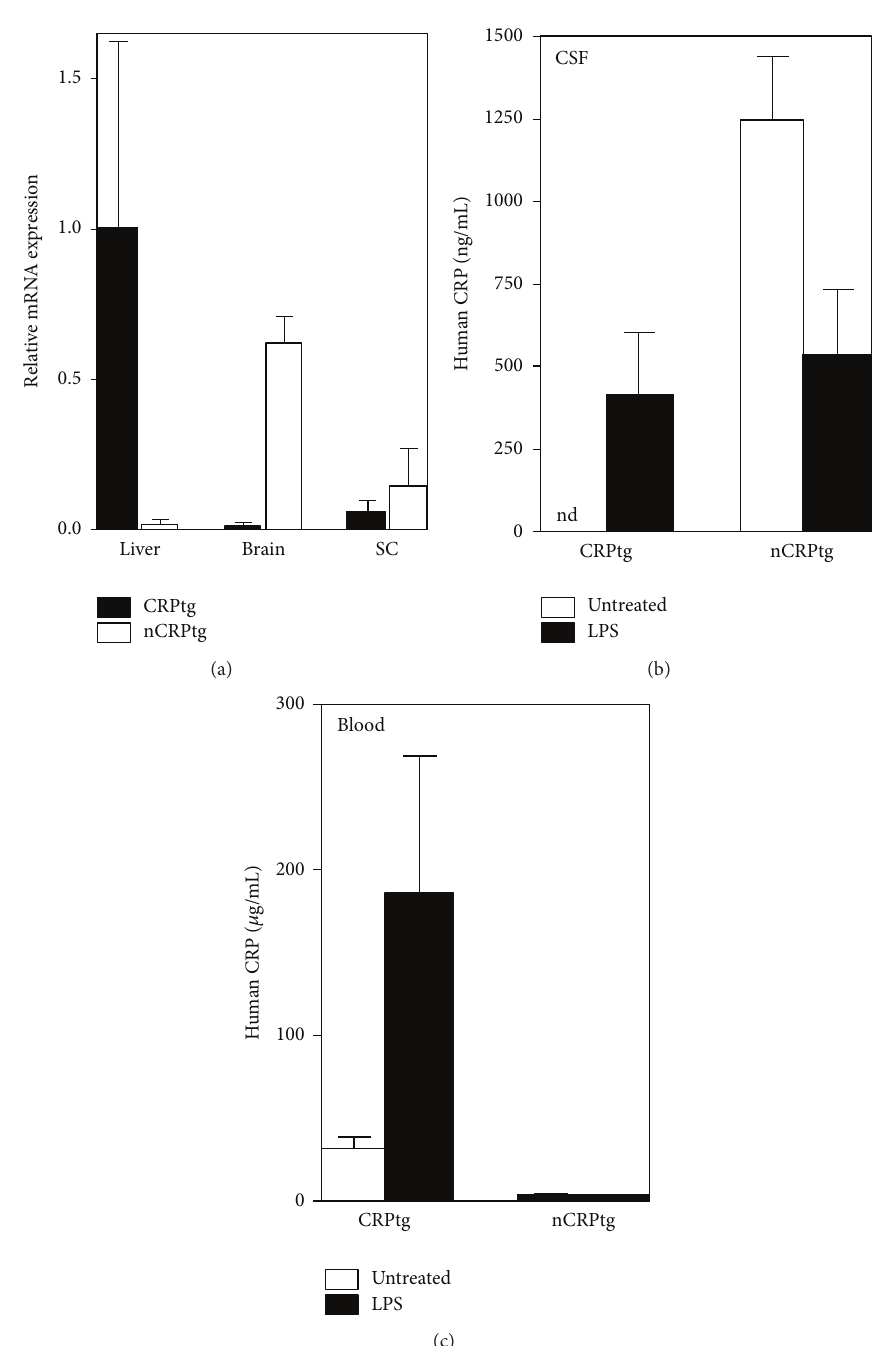
Figure 3: Human CRP is expressed exclusively in the CNS in nCRPtg mice. (a) qRT-PCR of mRNA isolated from livers, brains, and spinal cords (SC) of CRPtg (black bars) and nCRPtg mice (open bars). The data shown are from 𝑛 = 3 mice of each genotype and are normalized to baseline expression of CRP by CRPtg livers. Robust human CRP mRNA is detectable in the CNS of nCRPtg and in the livers of CRPtg. (b) Human CRP protein levels in the CSF collected from CRPtg and nCRPtg mice, injected with LPS, or left untreated ( 𝑛 = 3 mice per group). Human CRP was detected in the CSF of nCRPtg but was not detected (nd) in the CSF of CRPtg. (c) as in (b), but showing blood levels of human CRP, only detectable in the plasma of